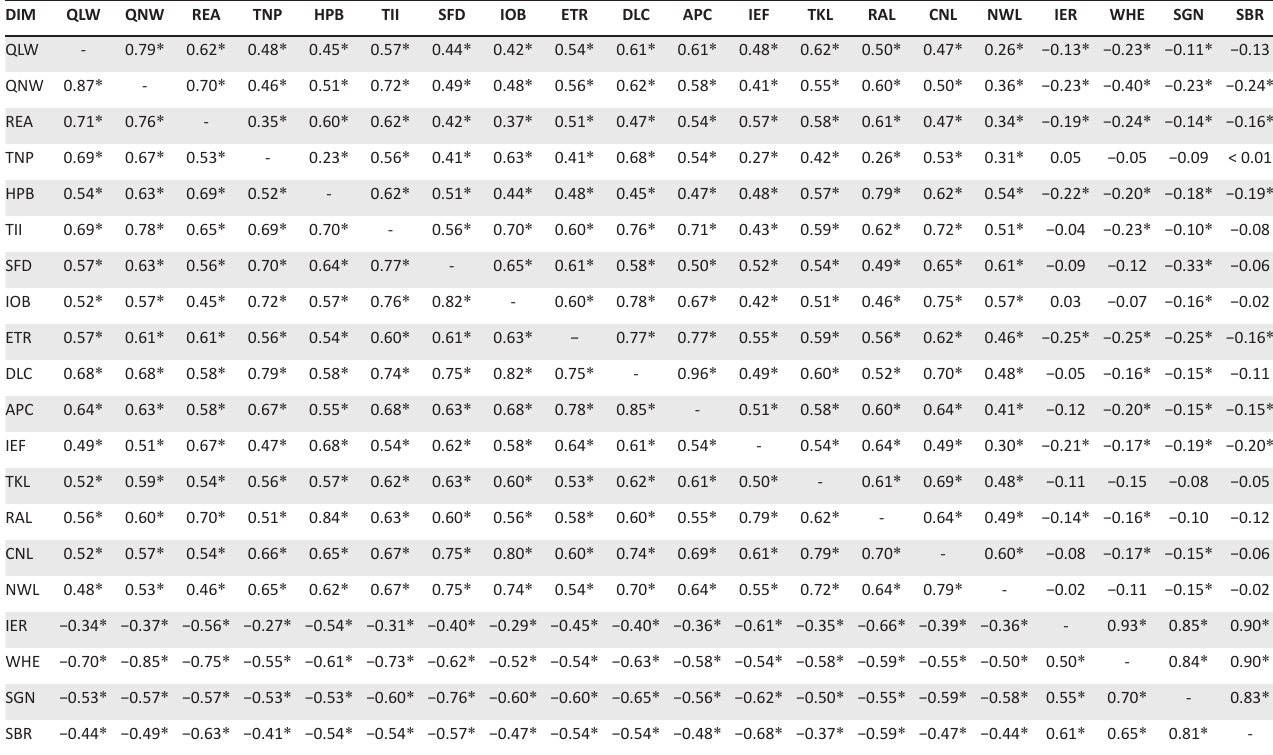
DIM, Dimension; QLW, Quality of work; QNW, Quantity of work; REA, Rule adherence; TNP, Technical performance; HPB, Helpful behaviours; TII, Taking initiative; SFD, Self-development; IOB, Innovative behaviours; ETR, Emotional resilience; DLC, Dealing with complexity; APC, Adapting to crises; IEF, Interpersonal flexibility; TKL, Task-orientated leadership; RAL, Relations-orientated leadership; CNL, Change-orientated leadership; NWL, Network-orientated leadership; IER, Interpersonal rudeness; WHE, Withholding effort; SGN, Stagnation; SBR, Stubborn resistance. * , p <